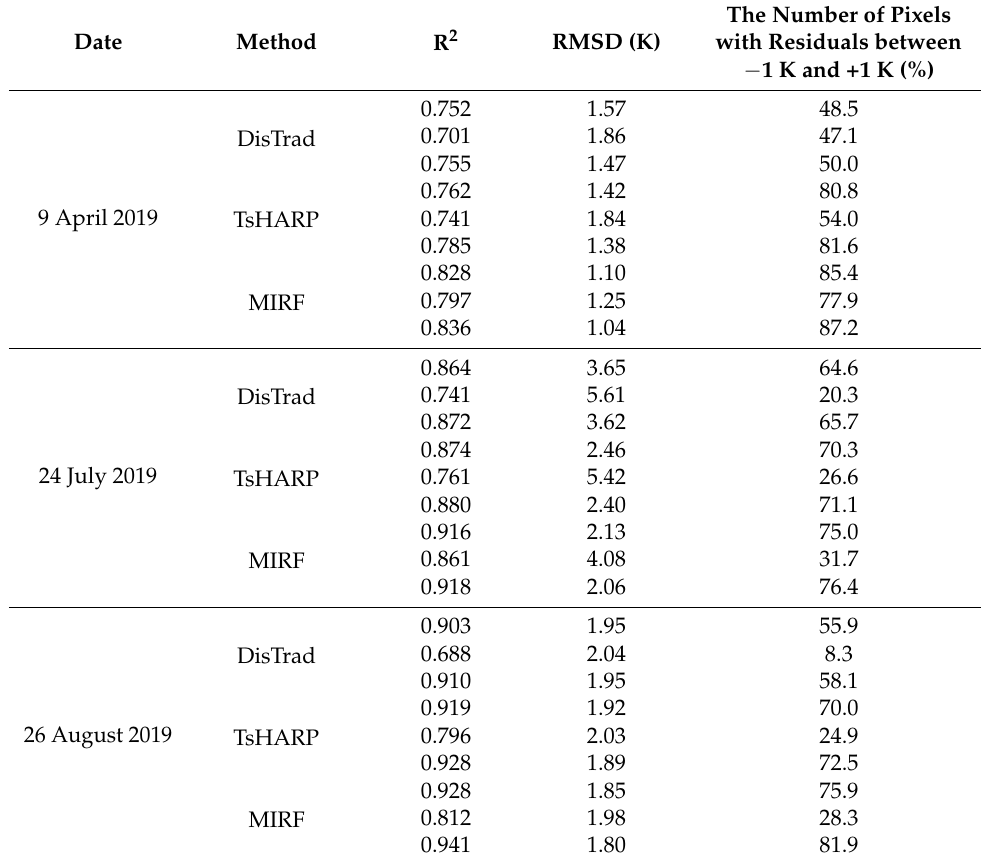
Table 4. The statistics for the three